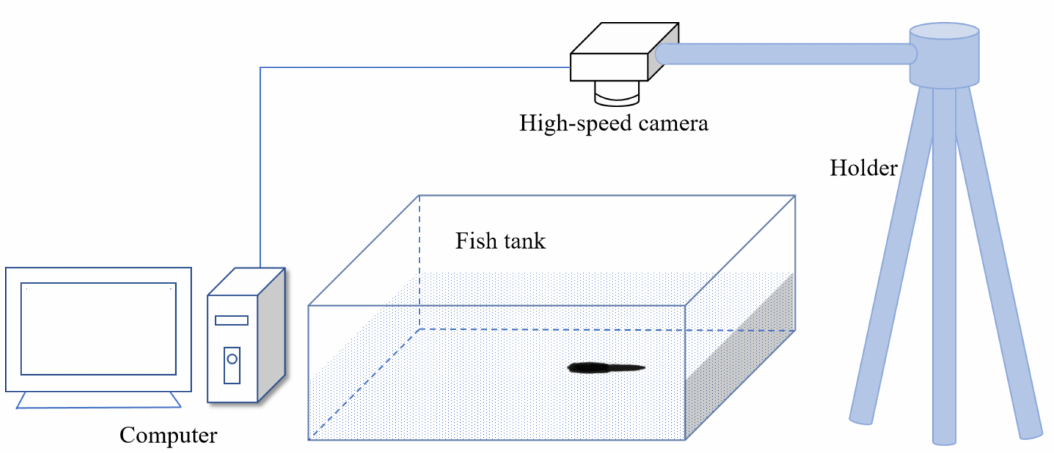
Figure 1. Diagram of the experiment